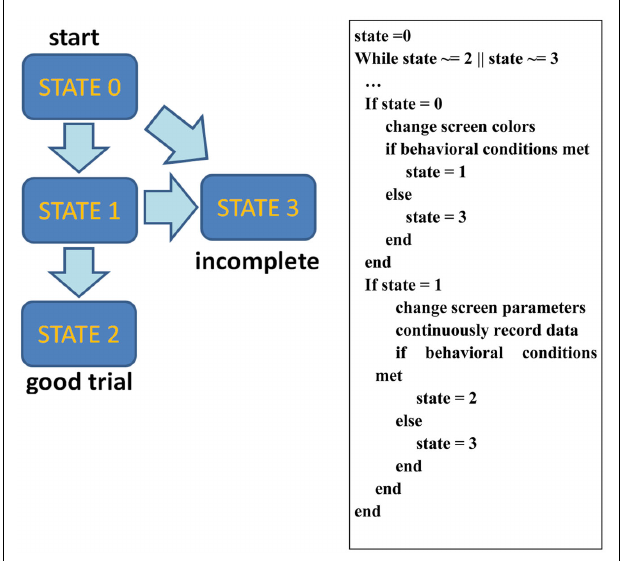
FIGURE 4 | State diagram, implemented with pseudocode starting with state 0, theWHILE loop will cycle until conditions are met to enter state 1, and likewise state 2. If these conditions are not met, state 3 is entered, indicating an incomplete trial.